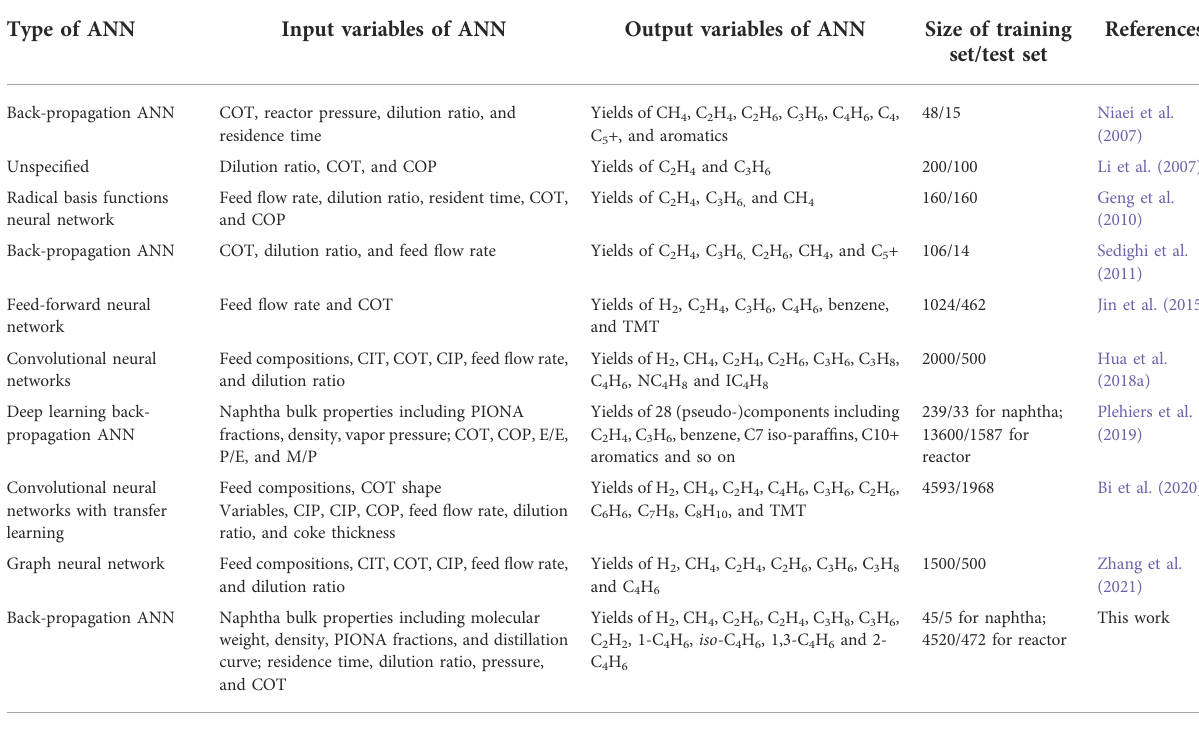
TABLE 1 Summary of the literature using ANN as a surrogate model.